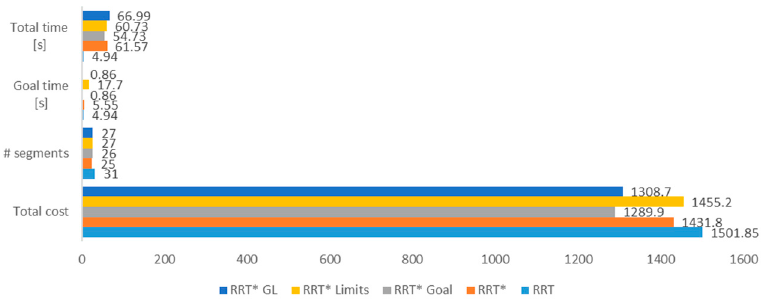
Figure 11. Results of the algorithms for the one obstacle scenario and 600 iterations.